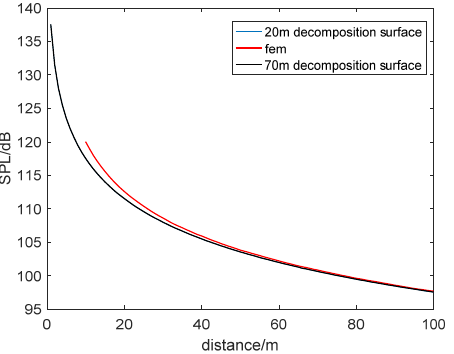
Figure 3. Comparison of the scattering field sound pressure calculated based on the spherical sound pressure decomposition method at different positions and the direct calculation result of finite element.